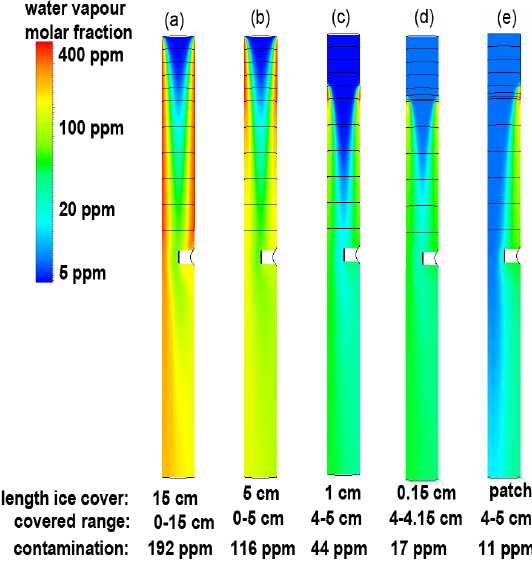
Figure 10. FLUENT simulation results for ice sublimation in the stratosphere with colour-coded H 2 O mixing ratios for p = 33hPa and T =− 58.7 ◦ C with different ice coverage of the intake (cid:105) = 192ppmv averaged over the tube: (a) 15cm with (cid:104) χ H Vol 2 O (cid:105) = 116ppmv, (c) 1cm tube volume, (b) 5cm with (cid:104) χ H Vol 2 O (cid:105) = 44ppmv, (d) 0.15cm with (cid:104) χ (cid:105) = 17ppmv with (cid:104) χ H Vol H 2 O Vol 2 O and (e) circumferentially asymmetric patch of 1 / 8 intake tube (cid:105) = 11ppmv. The circumference and 1cm length with (cid:104) χ H Vol 2 O triangular brackets indicate mixing ratios that have been averaged over the full tube volume. Images used courtesy of ANSYS,